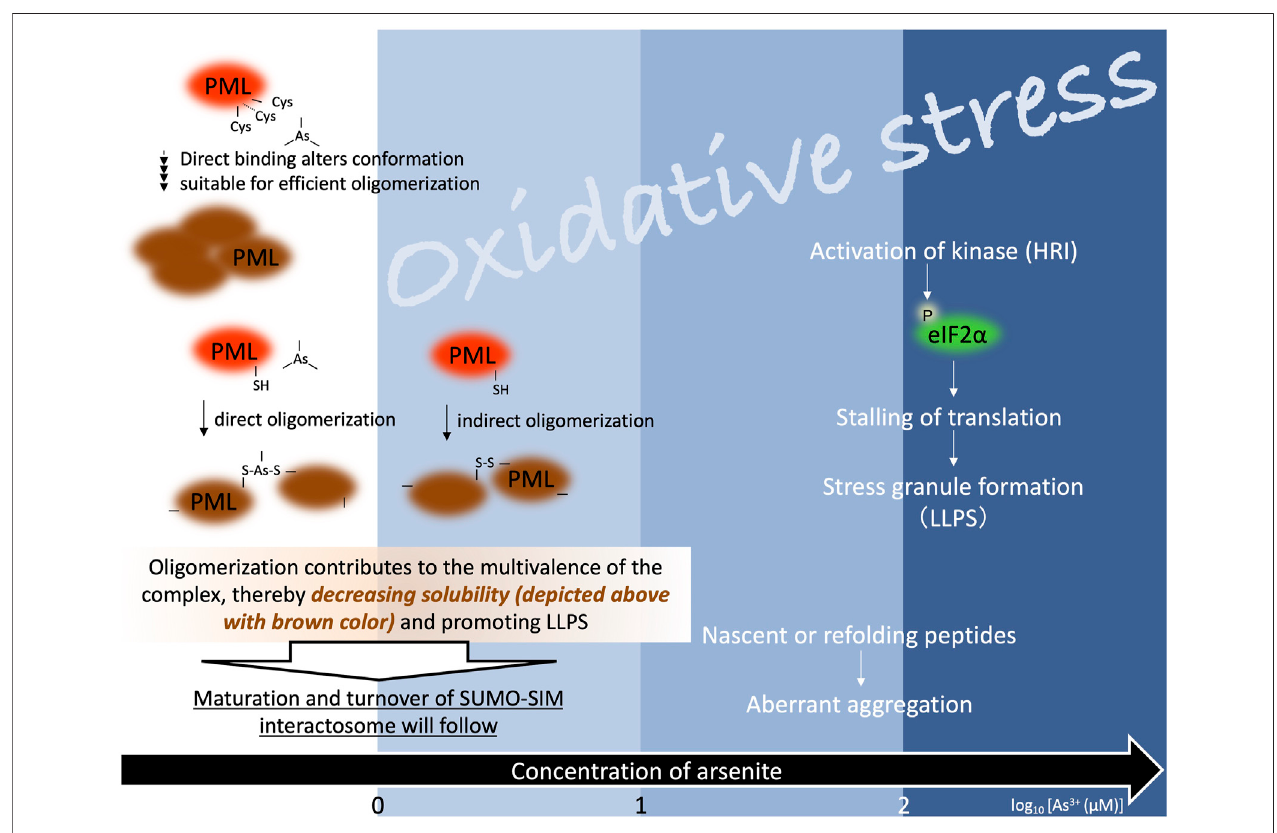
FIGURE 1 | Arsenite is involved in the formation of biomolecular condensates. The blue gradient colors represent different levels of oxidative stress at increasing concentration of arsenite. The numbers at the bottom indicate the logarithm of the arsenite concentration. Stress granule formation induced by higher concentration of arsenite is mediated by heme-regulated inhibitor kinase (HRI), which is one of four kinases targeting eIF2 α (eIF2 α -P: phosphorylated form of eukaryotic initiation factor 2 subunit alpha) (dark blue panel, the right side of the fi gure). Arsenite-dependent solubility changes of PML protein can occur below the level of oxidative stress induction (white panel, the left side of the fi gure). Tetramerization of PML protein can occur in the absence of arsenite. Although how intra-molecular arsenic binding facilitates inter-molecular interactions is unknown, arsenite promotes oligomerization of PML protein. Further, regarding the promotion of inter-molecular interactions, arsenite acts as an indirect (i.e., oxidation-dependent -S-S- formation via oxidative stress) as well as direct (i.e., arsenic crosslinks PML polypeptides) oligomerizer. Like PML protein, client proteins in PML-NBs often possess small ubiquitin-like modi fi er (SUMO) conjugation sites and SUMO interaction motif (SIM). Arsenite-dependent solubility change of PML protein is followed by SUMOylation. SUMO-SIM-rich environment of PML-NBs is likely to be advantageous for multiple biological functions. SUMOylated PML protein is further ubiquitinated by the SUMO-dependent ubiquitin E3-ligase and adequately degraded via the ubiquitin-proteasome system.